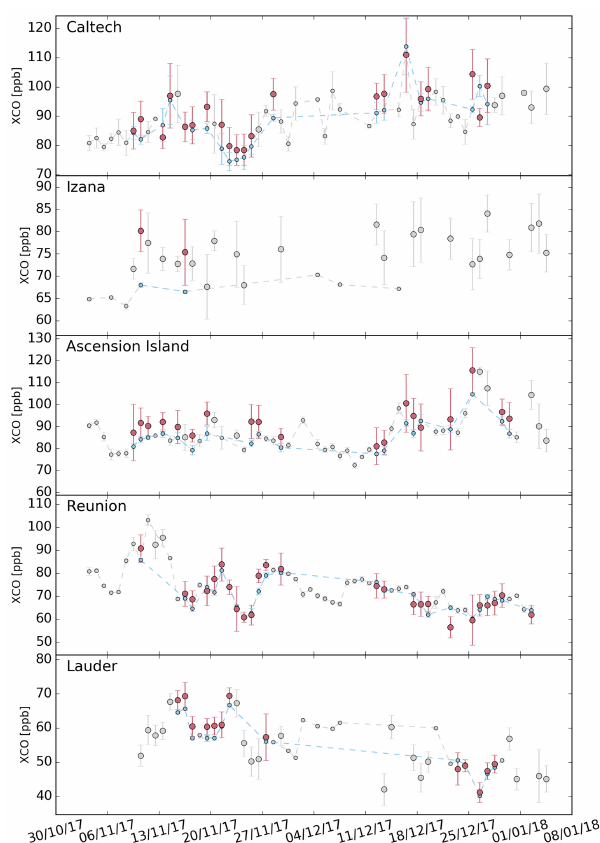
Figure 4. As Fig. 3 but with different TCCON stations.